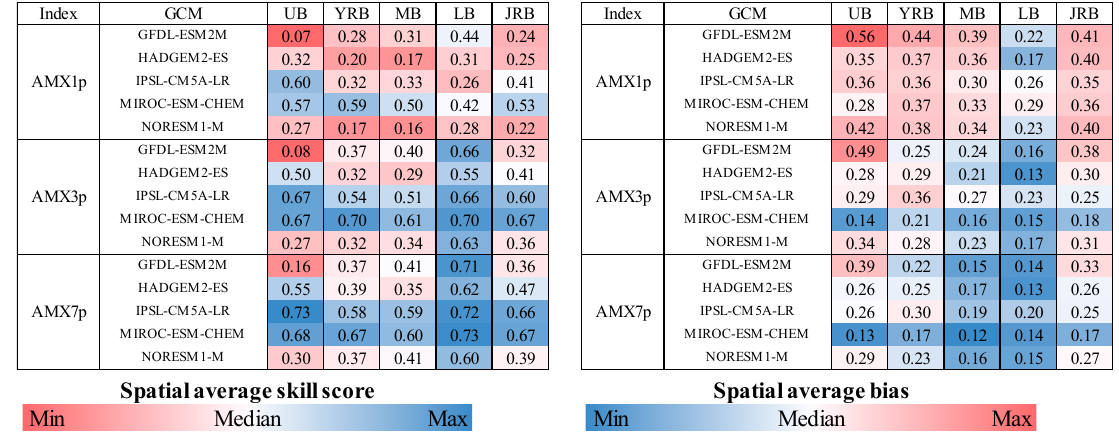
Figure 5. The Spatial average skill score ( left ) and bias ( right ) for the five GCMs. Note: UB-Upper basin; YRB-Yalong River Basin; MB-Middle basin; LB-Lower basin; JRB-Jinsha River Basin.